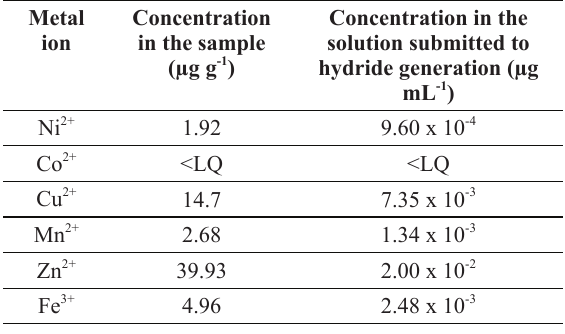
Concentration of potentially interfering metal ions in hair sample composed by material from several donors.